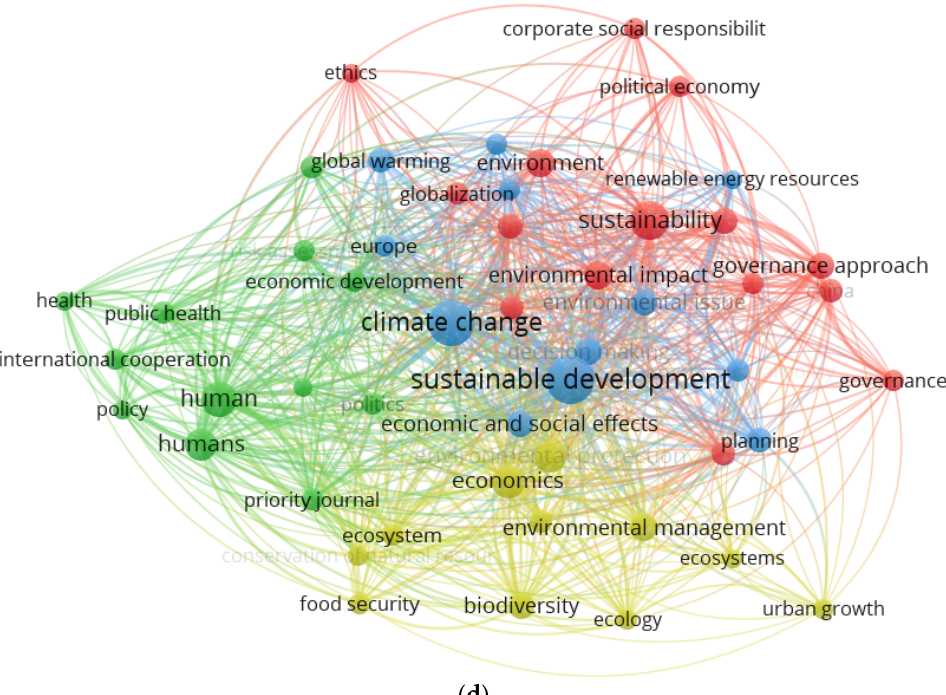
Figure 7. Co-occurrence of keywords analysis during the period ( a ) 1980–1989: 26 documents (14